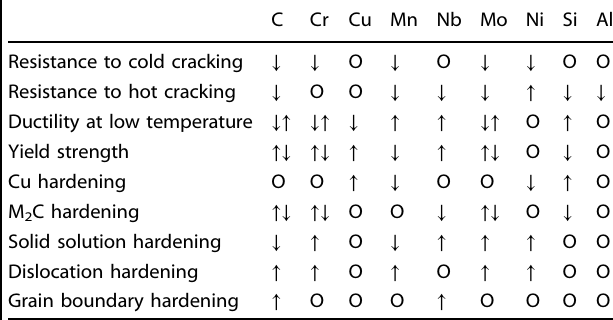
Fig. 5 Predicted yield strength and the contribution from different strengthening mechanisms versus carbon content. a Average strength from different strengthening effect versus carbon content, precipitation strengthening effect from b Cu precipitation, c M 2 C precipitation, and d sum of Cu and M 2 C precipitates. Table 2. Summary of the in fl uence of elements in HSLA-115 on the key properties 1,2 , for each screening